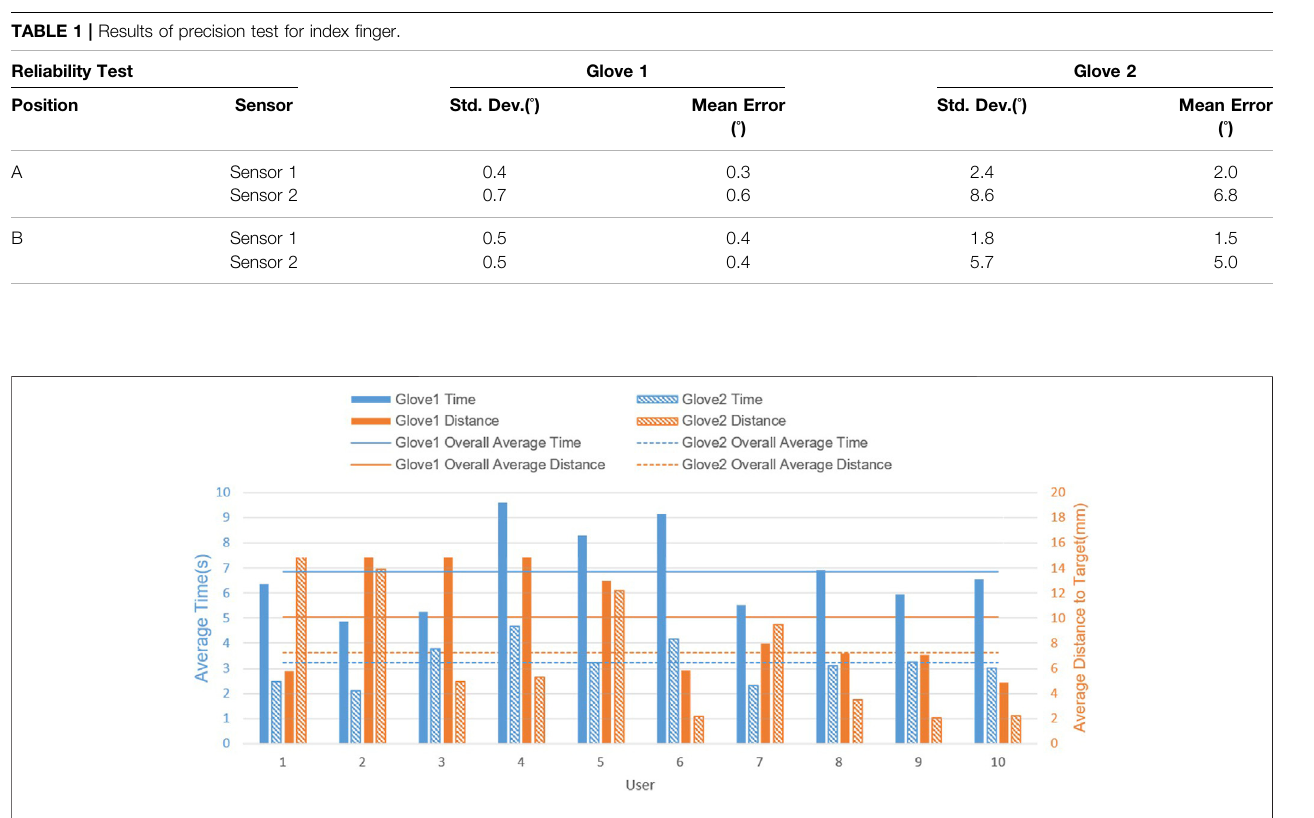
FIGURE 7 | Result of interaction ef fi ciency